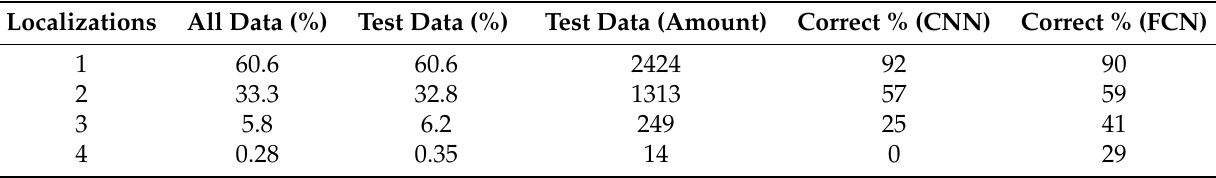
Figure 5. Examples of successful classification. Confidence values are represented with dark green in the plots, and thresholds for each class are lighter bars. The annotated classes are labeled in green. Successful examples include sites with a good reference due to additional stainings, such as microtubules ( a ) and nucleus ( b – e ); localization to major classes such as the cytoplasm ( c , e ); and clearly distinguishable phenotypes such as vesicles ( d ). Actin filaments is a rare class and, thus, difficult to detect ( e ). Table 1. Comparison of results based on multilocalization of proteins. Localizations refers to the number of classes present in an